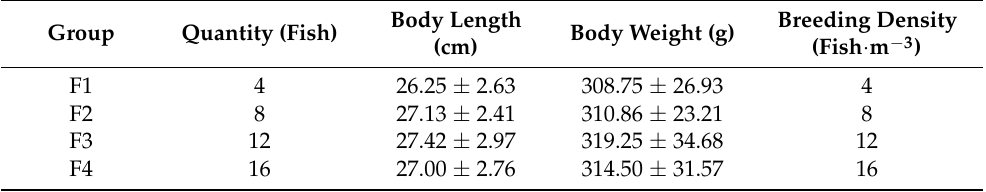
Table 1. Grouping table of test